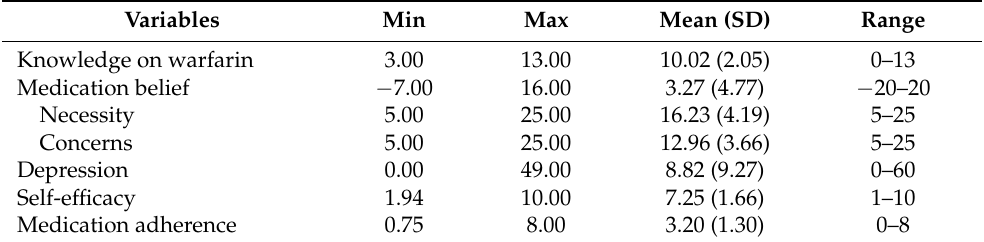
Table 2. Knowledge on warfarin, medication belief, depression, self-efficacy, and medication adher- ence (n = 154).